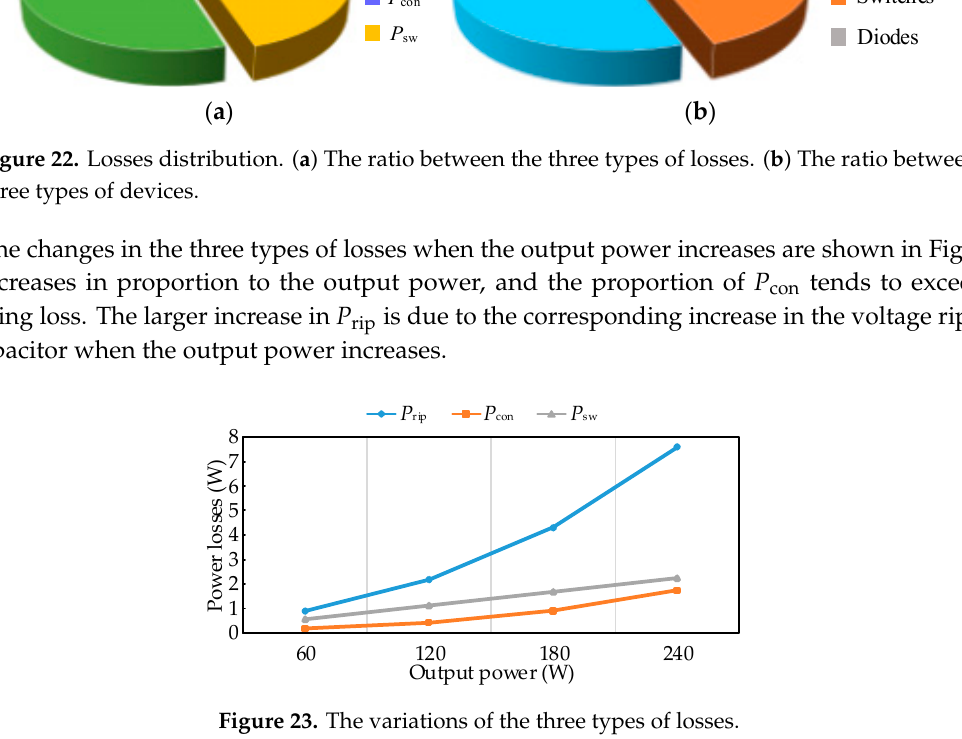
Figure 21. Experimental results when f o changes. ( a ) f o changes from 50 Hz to 100 Hz. ( b ) f o changes from 50 Hz to 25 Hz.